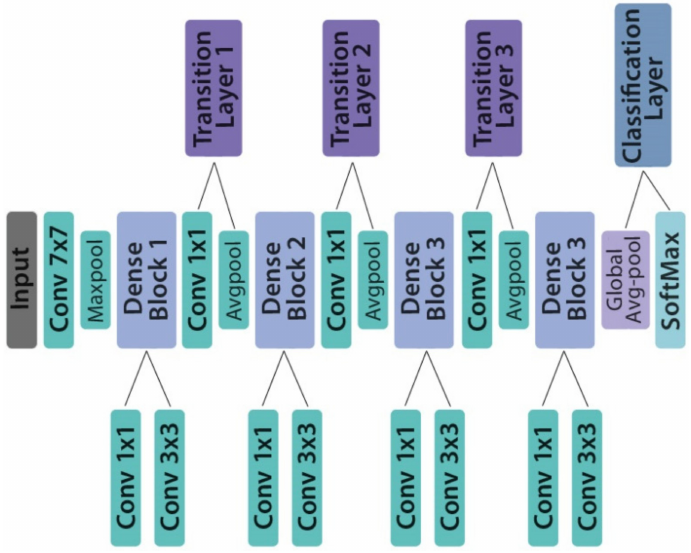
Figure 11. The structure of DenseNet201